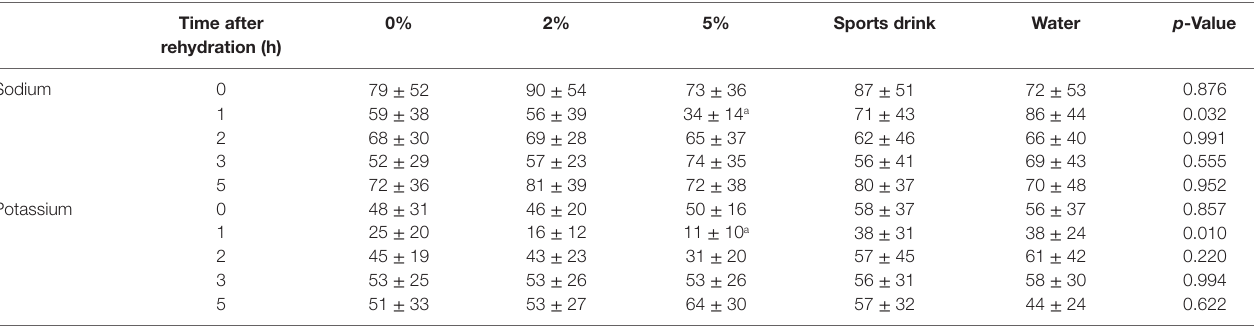
Data are presented as mean ± SD and expressed in mmol L − 1 . a Significantly different from sports drink (post hoc test p < 0.05).